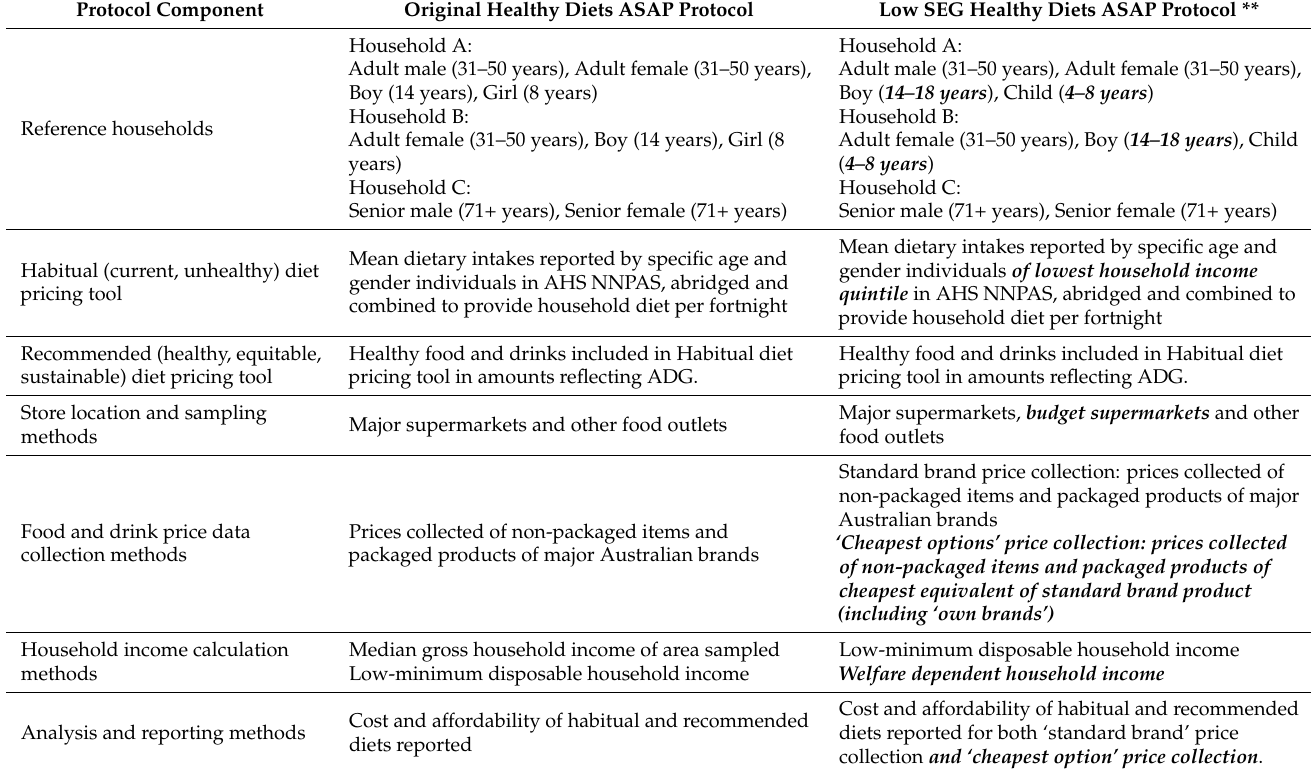
Table 1. Components of the original Healthy Diets ASAP protocol and the Low SEG Healthy Diets ASAP protocol. Protocol